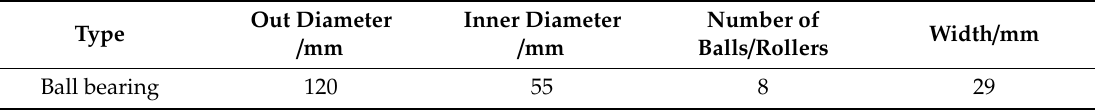
Table 1. Basic dimension parameters of a ball bearing in the traction motor of a high-speed EMU.